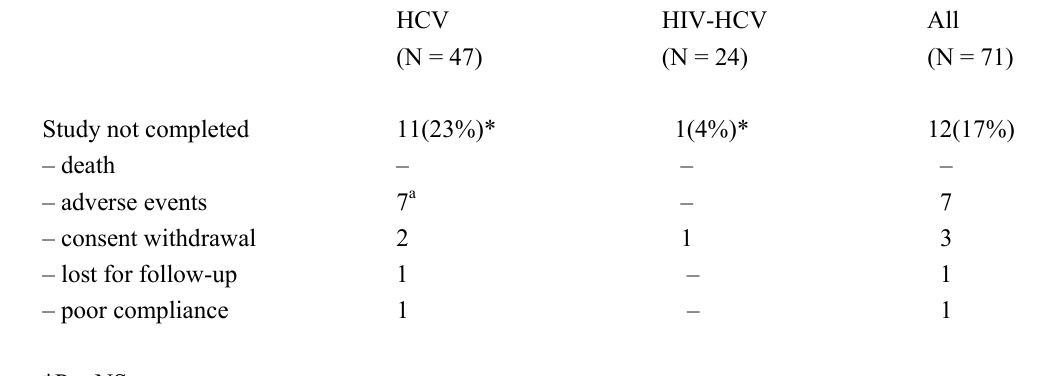
Frequency and percentage of adverse events and reasons for not completing the study (genotypes 2 and 3).